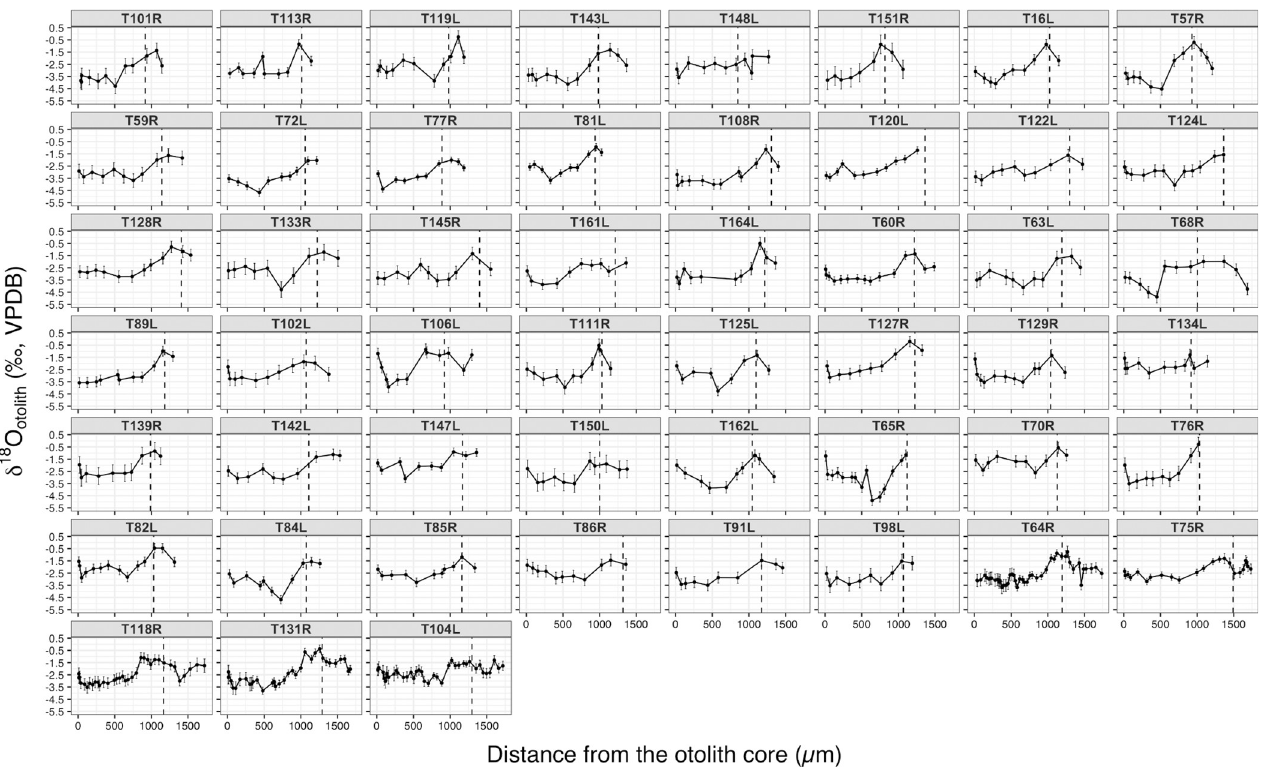
Fig 4. The δ 18 O otolith chronologies recording the early life and immature stages of adult Pacific bluefin tuna. Error bars indicate the spot-to-spot precision of SIMS analyses ( ± 2SD). Dashed vertical lines indicate the location of the first opaque zone (a dark line-like structure formed in winter) in otoliths corresponding to the lowest temperature experienced by an individual fish in winter.